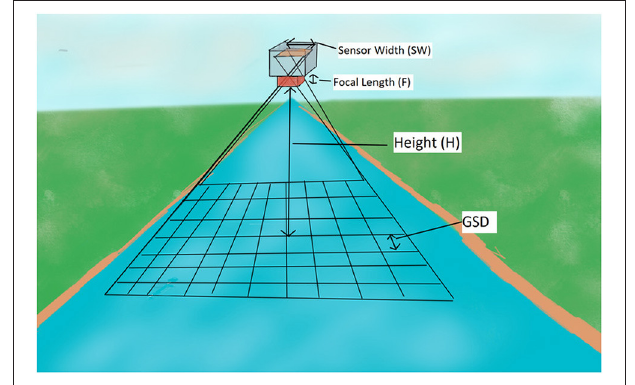
FIGURE 4 | Schematics of GSD of Nadir